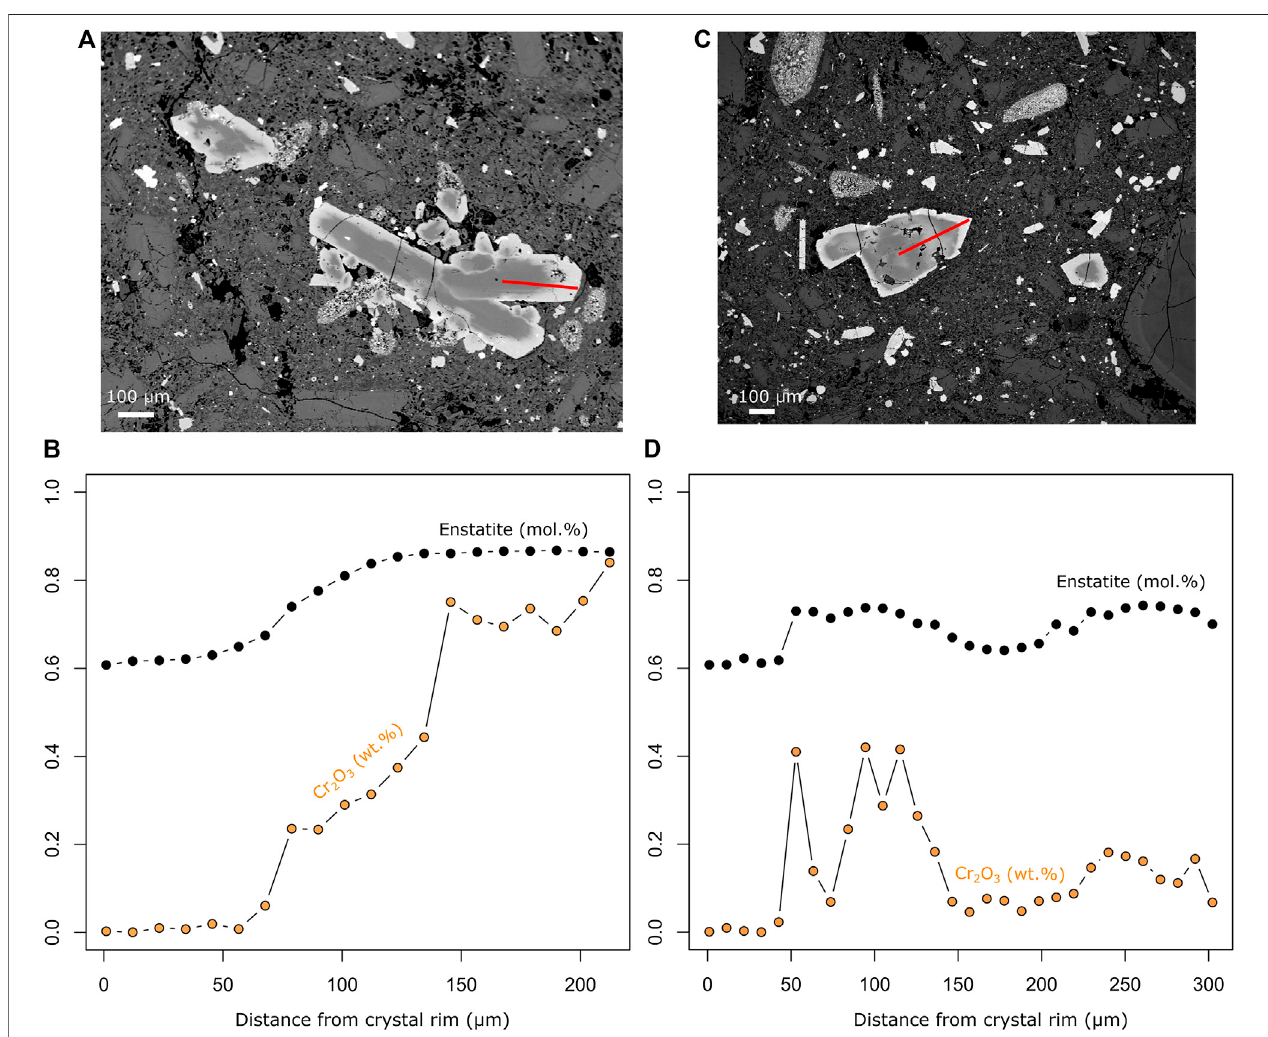
FIGURE 7 | Evidence for magma hybridization in orthopyroxene crystals. (A) Microphotograph (BSE) of strongly zoned opx in Crater U25 magma. Dark cores correspond to ma fi c Cr-rich magma and bright overgrowth rims to the erupted dacite. Note the wavy resorption textures at the interface of bright and dark zones. Red lineindicatesanalyticaltraverse. (B) Enstatite(En)inmol%andCr 2 O 3 areplottedvs.distancefromthecrystalrim(µm)forthepro fi leinA. (C) BSEimageofstronglyzoned opxcrystalswithindicatedelectronprobemicroanalyzer pro fi leinCraterU25magma. (D) Chemicalpro fi leofEn(mol%) andCr 2 O 3 (wt%)forthepro fi leshowninC.